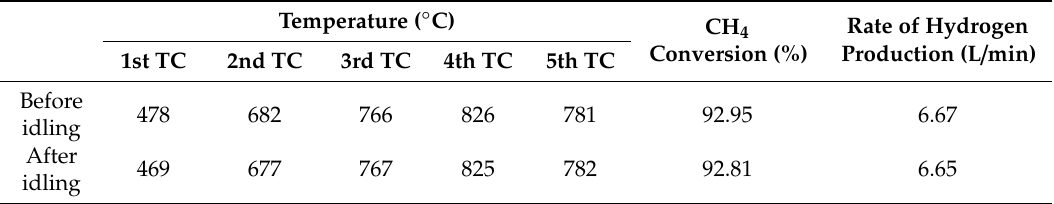
Table 4. Textural properties of the catalyst used herein.